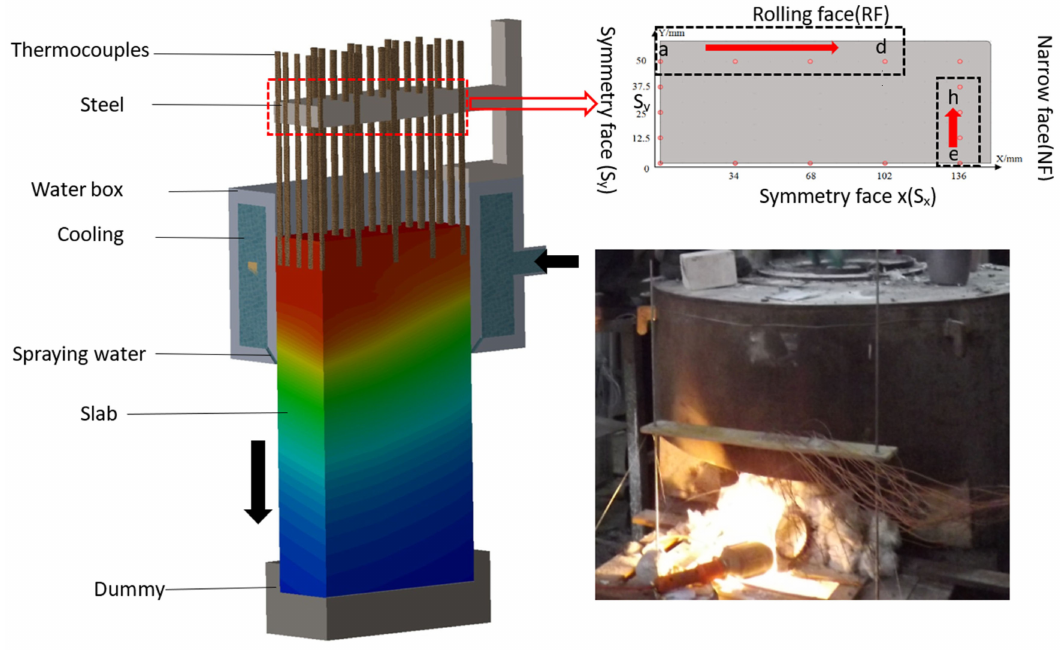
Figure 1. Schematic illustration of temperature measurement during DC